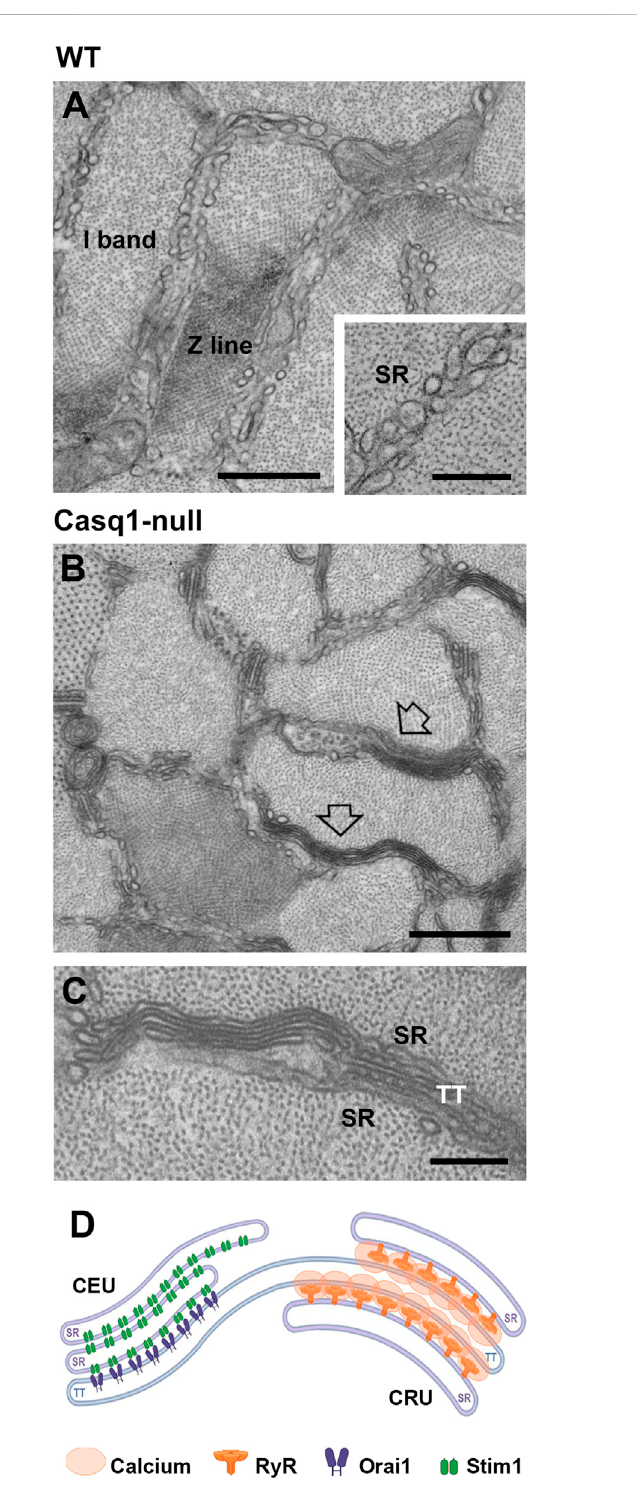
FIGURE 2 RepresentativeEMimagesofSRattheIbandofWTandCasq1-null fi bersandschematiccartoonofSRremodelinginCasq1-null fi bers. (A) SRat IbandofWTEDL fi bersappearasSRvesiclesandsmalltubes. (B,C) InCasq1-nullEDL fi bers,SRattheIbandisoftenremodeledinSR-stacks(pointed byemptyarrows),onethetwocomponentsofCEUs. (D) CartoonshowingaCEUandaCRU,whicharebothjunctionsbetweenSRatTT,thoughthey contain different proteins (see symbol legend). Scale bars: (A,B) , 0.2 μ m; inset in (A,C) 0.5 μ